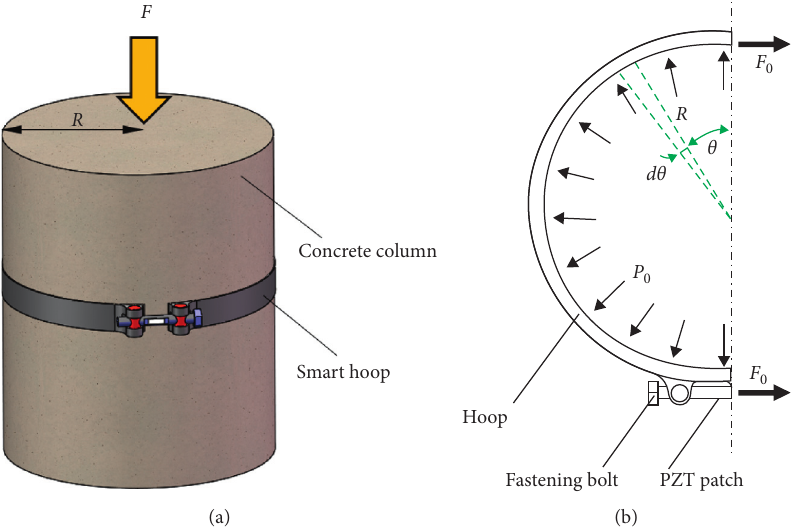
Figure 2: Loading diagram when the column is subjected to the axial load: (a) the column installed with the smart hoop; (b) the cutaway view for the smart hoop.